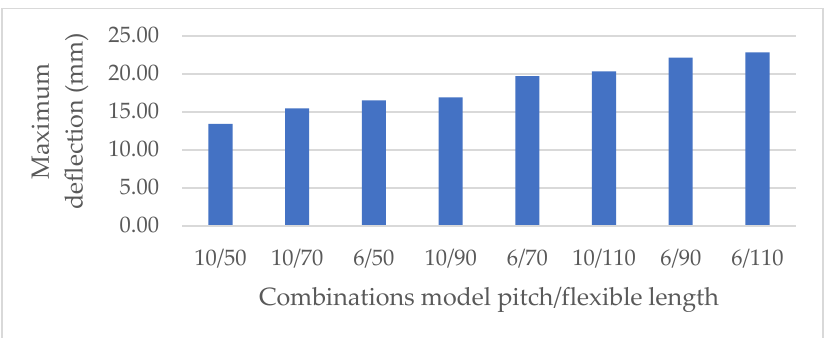
Figure 10. Mean values of the maximum deflection for combinations of model pitch and flexible length.